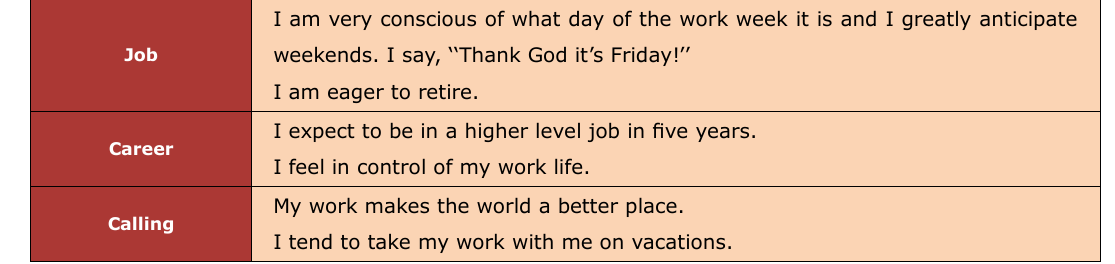
Table 5. Work orientations